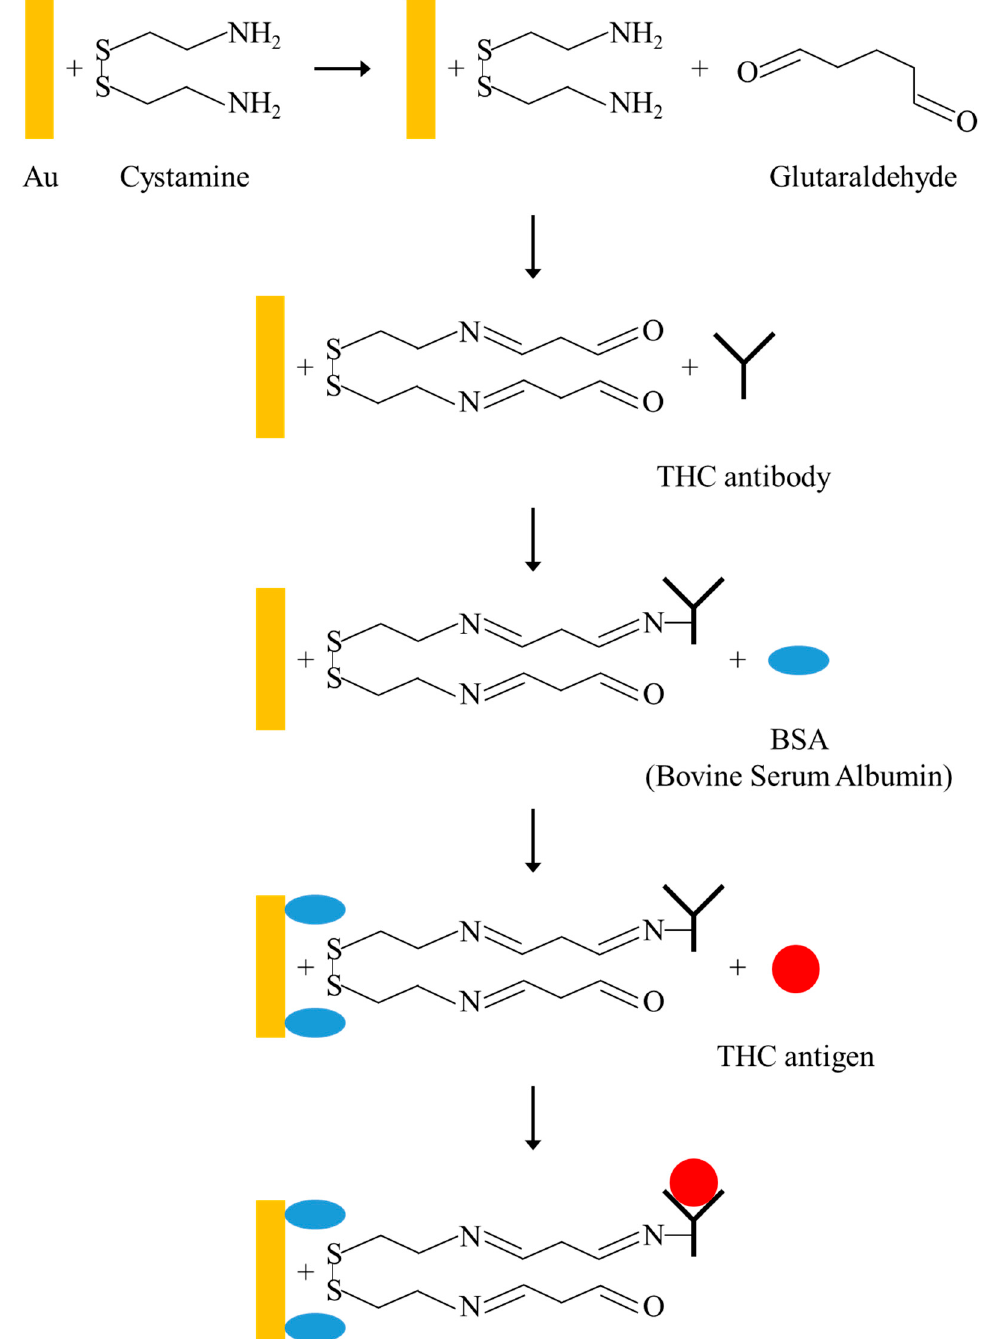
Figure 2. Schematic diagram for the integration of cystamine SAM, glutaraldehyde, THC antibody, and THC antigen in multilayers.